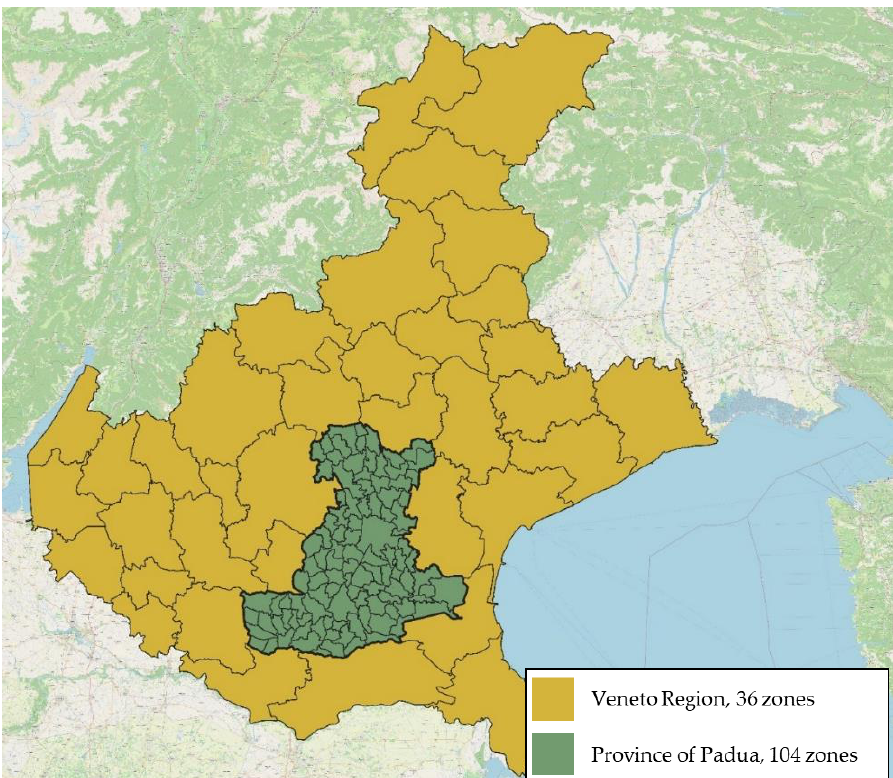
Figure 1. Study area and zoning.